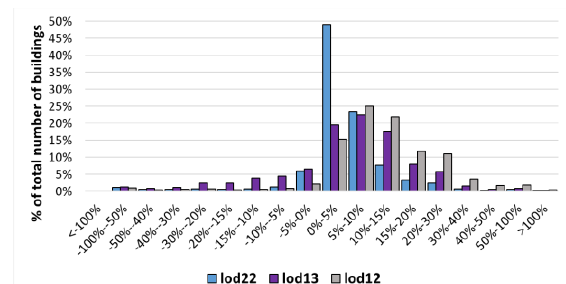
Figure 5. Distribution of volume differences (in %) between the LoDx models and the nDSM model.